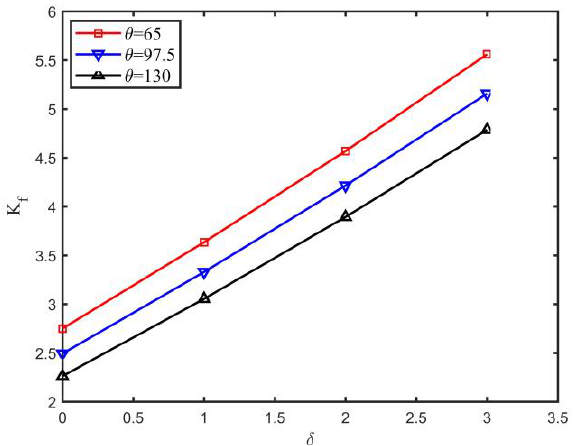
Figure 10. The effect of axial misalignment (h = 2 mm W i = 10 mm).